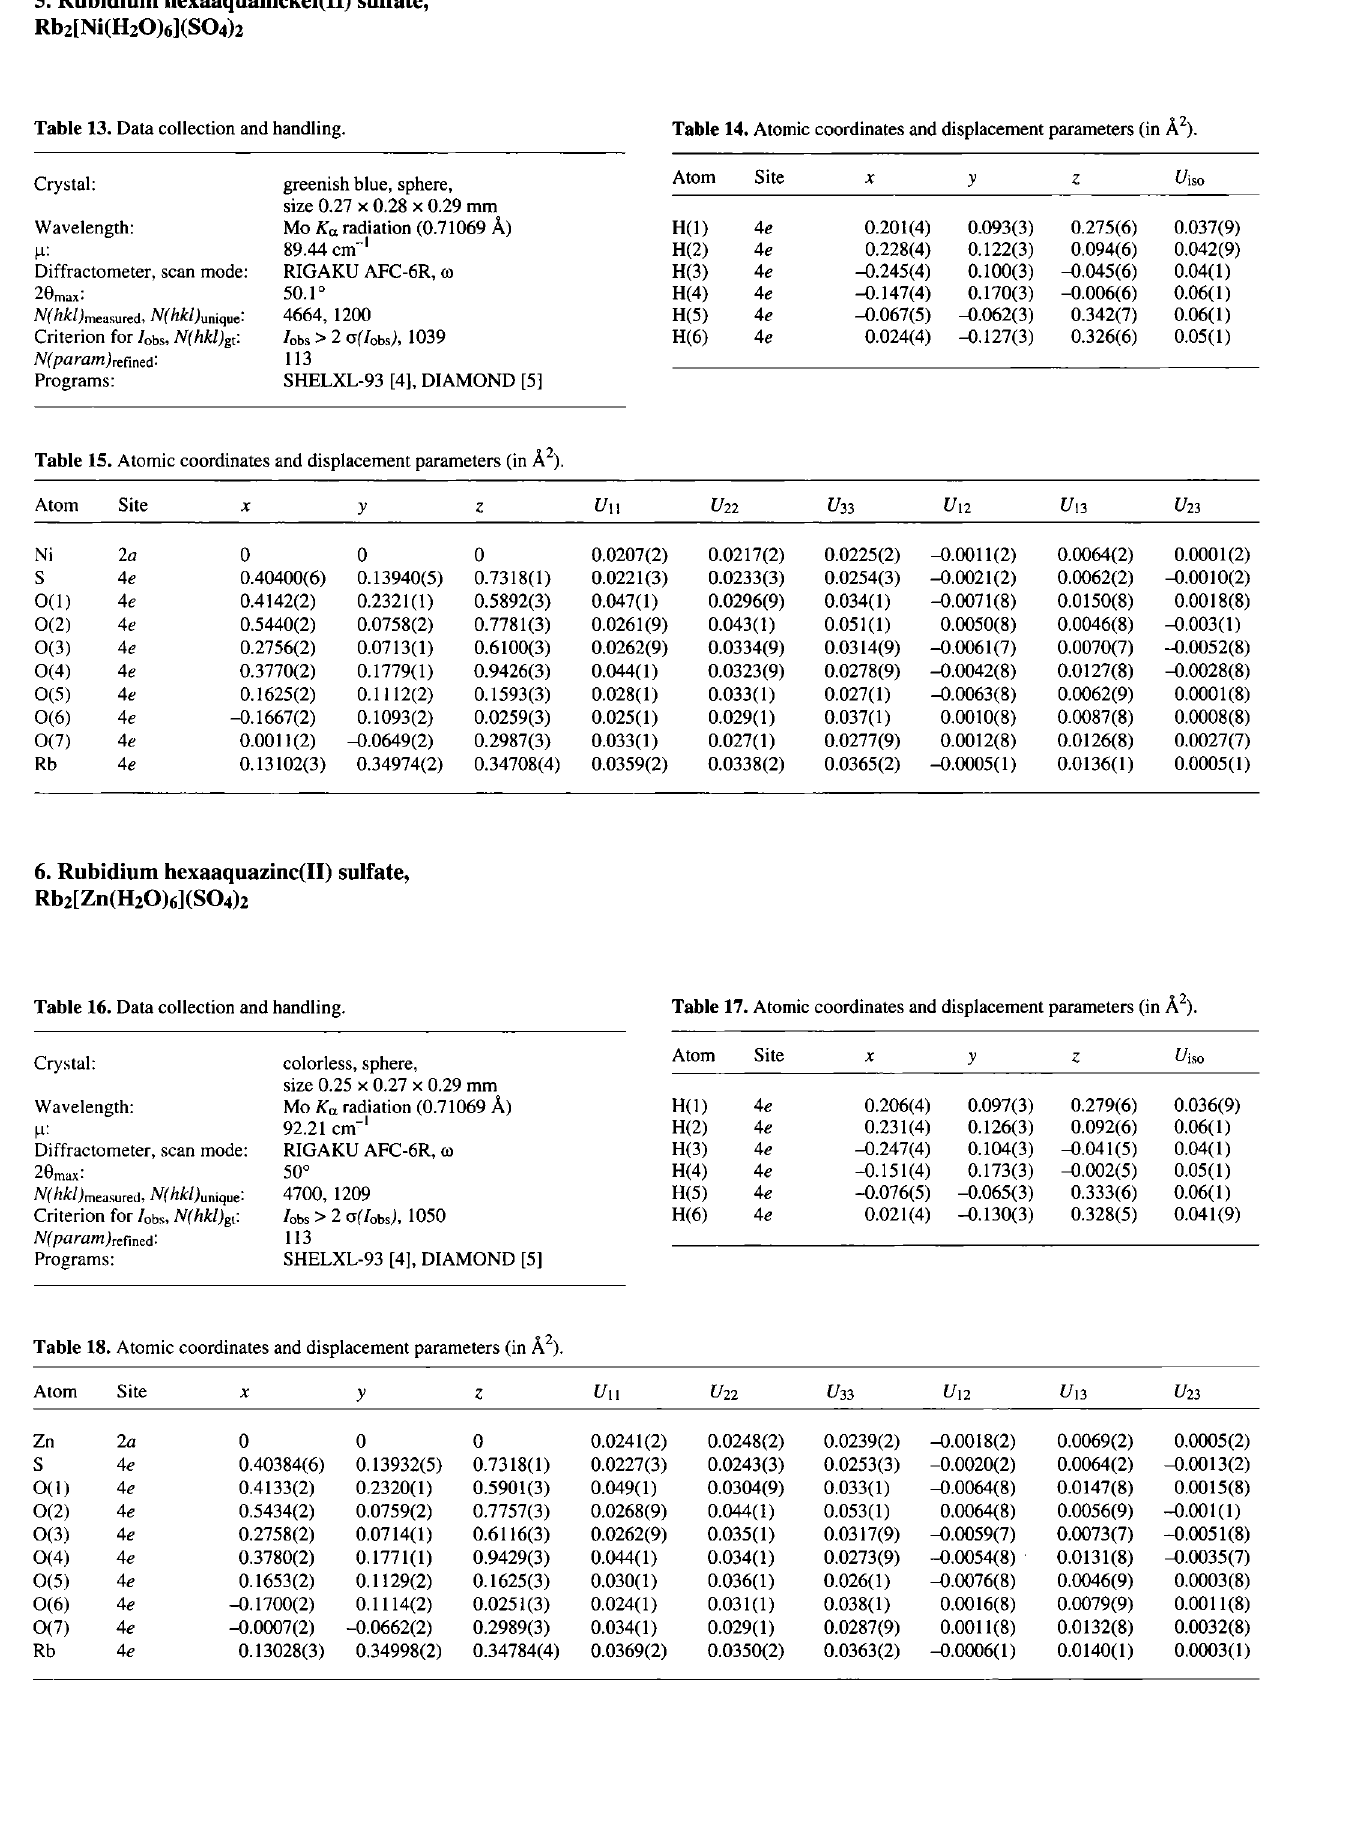
Table 13. Data collection and handling. Table 14. Atomic coordinates and displacement parameters (in A 2 ).